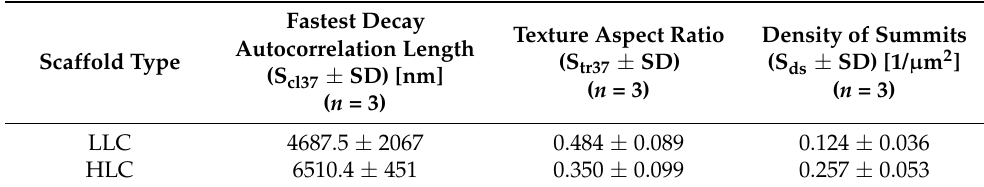
Figure 9. AFM topographic images obtained for the LLC scaffold over 100 × 100 µm area ( a , b ), and the corresponding profiles taken at locations marked with 1 ( c ), 2 ( d ), and 3 ( e ).